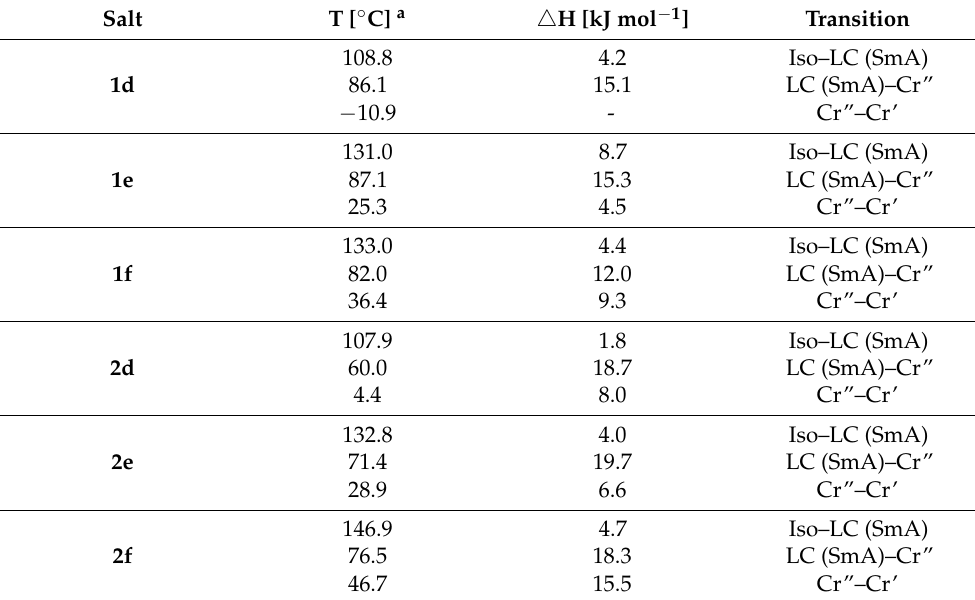
Table 2. Transition temperatures (T), enthalpies ( (cid:52) H) and the phase transition of the salts 1d-f and 2d-f obtained from the DSC traces upon cooling with 10 ◦ C min − 1